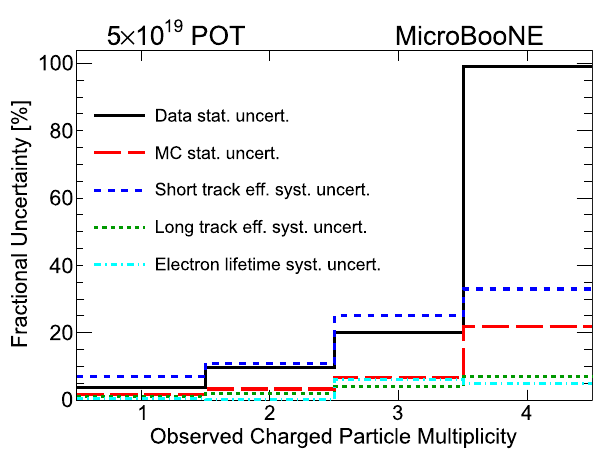
Fig. 9 Percentage uncertainty distributions from different systematic and statistical sources as a function of observed charged particle multi-